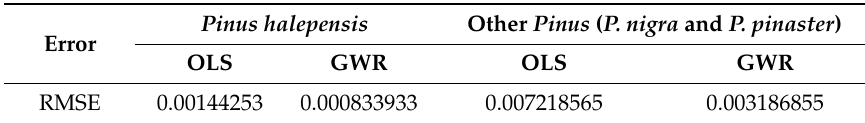
Table 8. Root-mean-square error (RMSE) from Regression models. Pinus halepensis Other Pinus ( P. nigra and P. pinaster ) Error